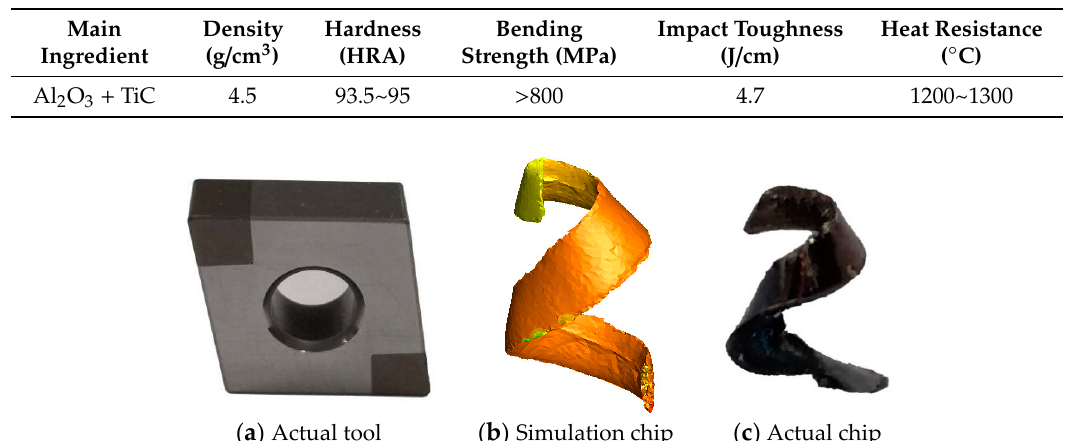
Table 6. Composition and mechanical properties of the ceramic tools.